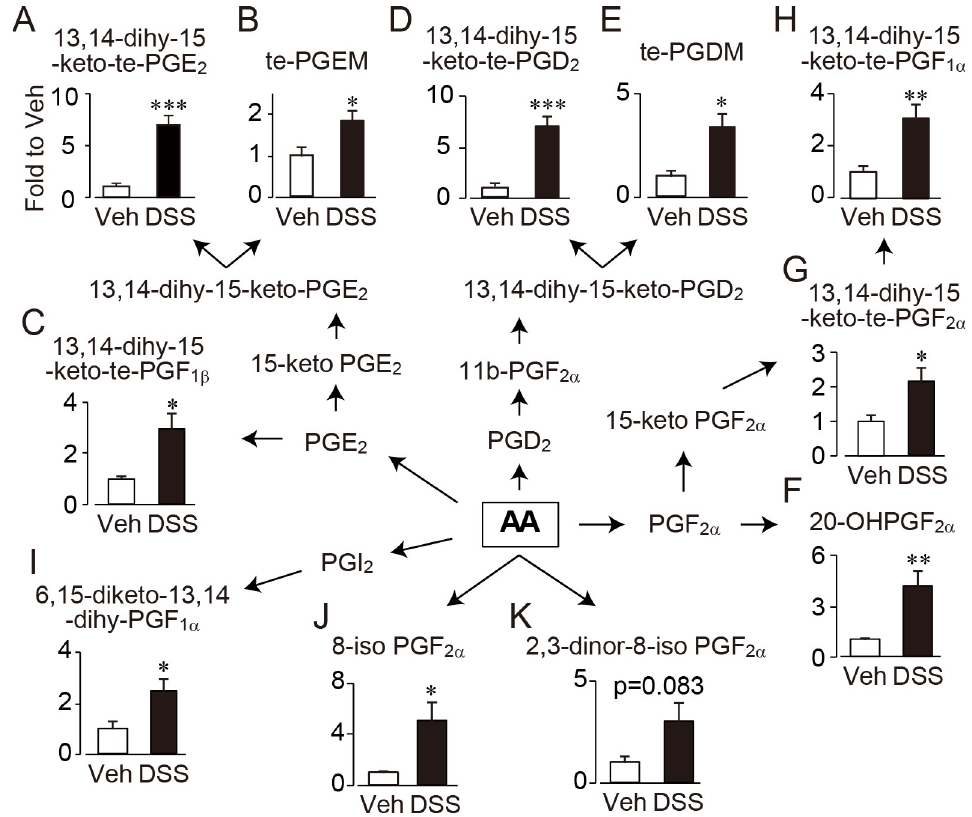
Fig 2. Increased urinary lipid metabolites in CAC mice. Lipid metabolites were comprehensively measured in the urine of vehicle or DSS administrated mice (n = 7 each). dihy, dihydro; te, tetranor; PG, prostaglandin; TX, thromboxane; AA, arachidonic acid. � , p < 0.05; �� , p < 0.01; ��� , p < 0.001.